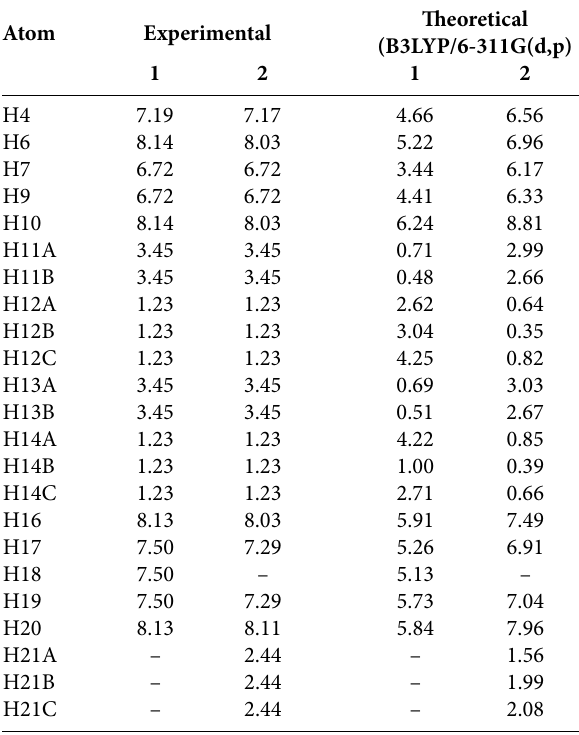
Table 5 . Comparison of the experimental and calculated 1 H NMR values in chloroform.